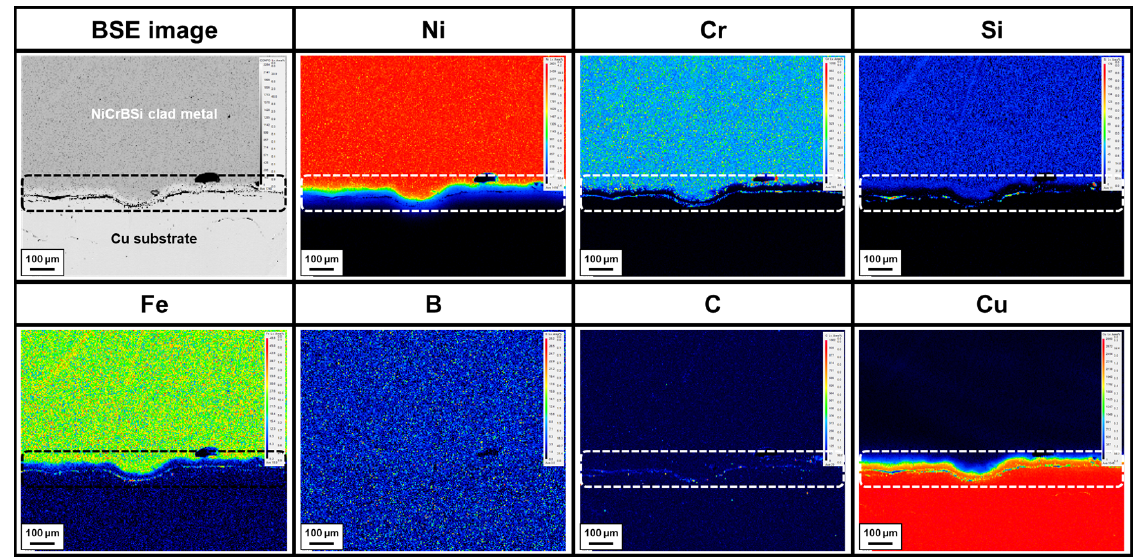
Figure 9. BSE image and elemental distribution maps obtained by EPMA near the faying surface for heat-treated clads (1223 K for 500 min).